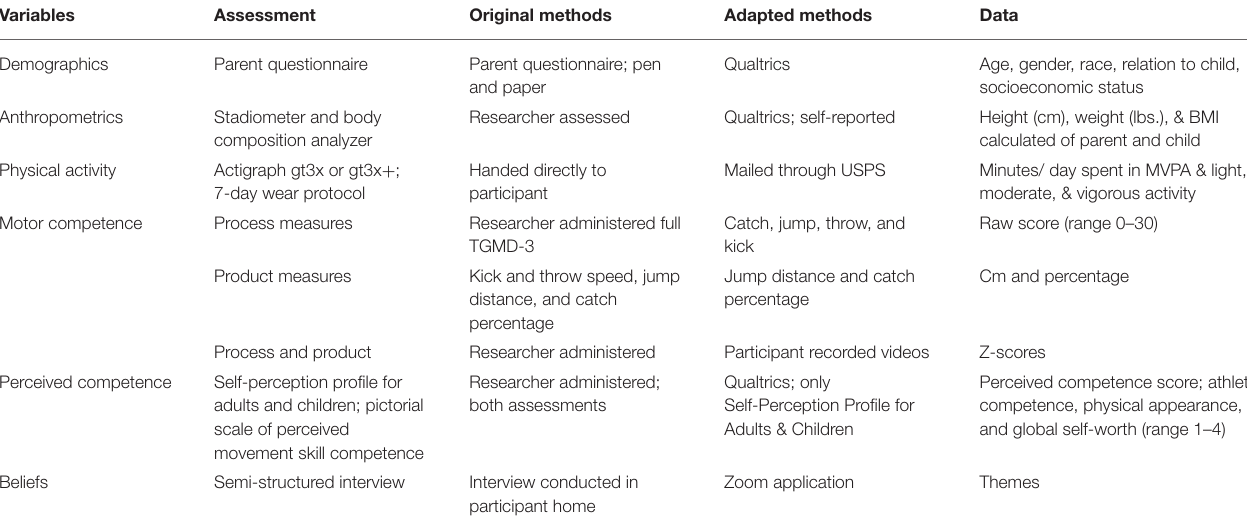
TABLE 1 | Previous and adapted methods by research